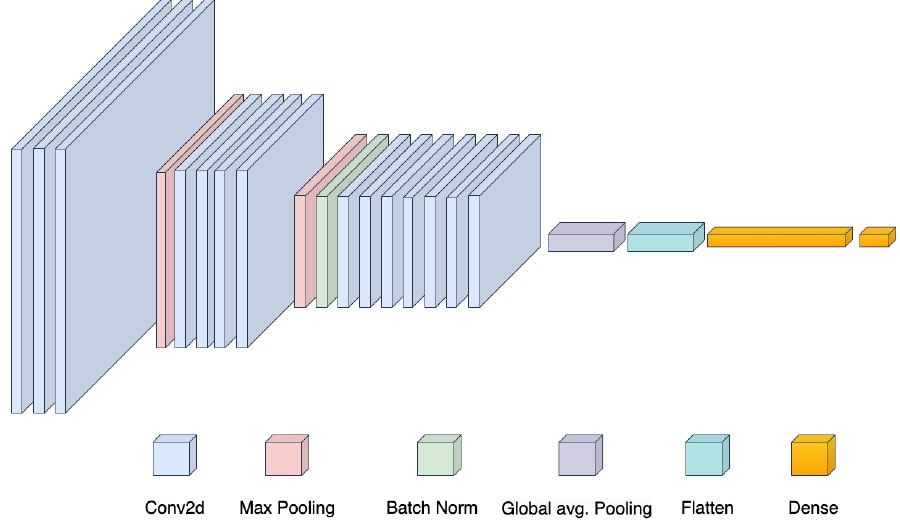
Figure 4. Proposed